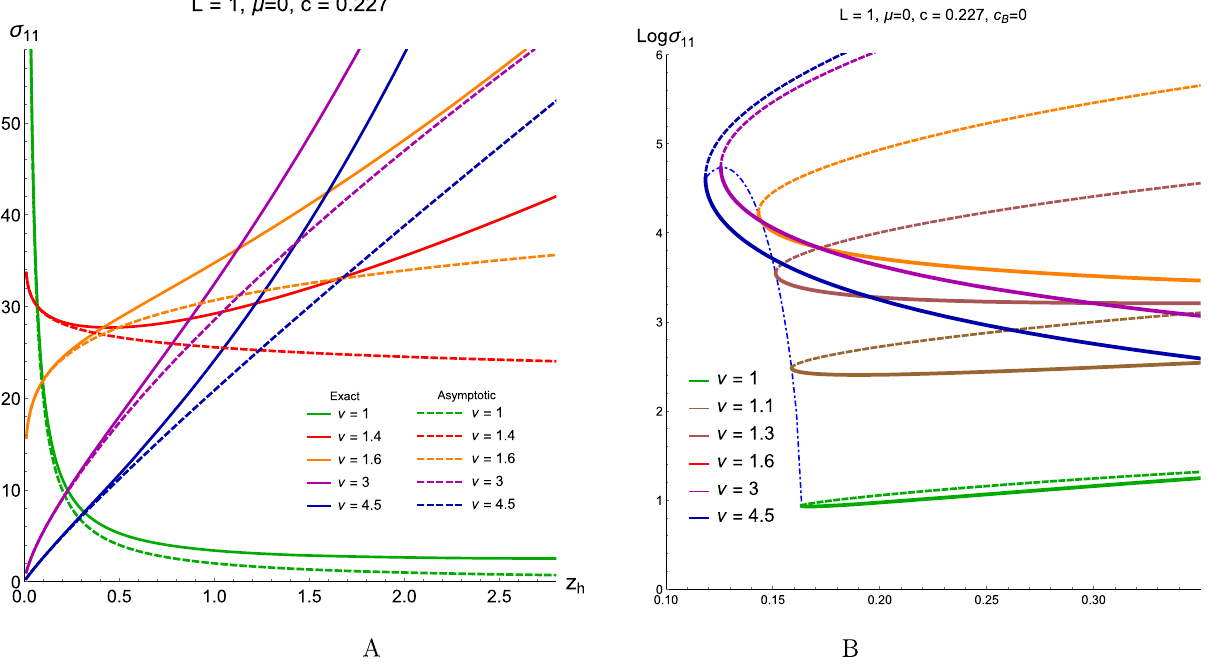
Fig. 2 A The dependence of the electric conductivity σ 11 on the size of horizon z h for different values of anisotropy parameter ν and zero magnetic field c B = 0. The solid lines show exact calculations, while dashed correspond to asymptotics around z h = 0. B The dependence of electric conductivity σ 11 on the temperature T for different values